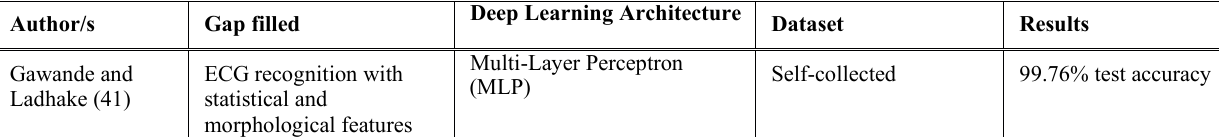
Table 3. Important works on ECG based identification using deep